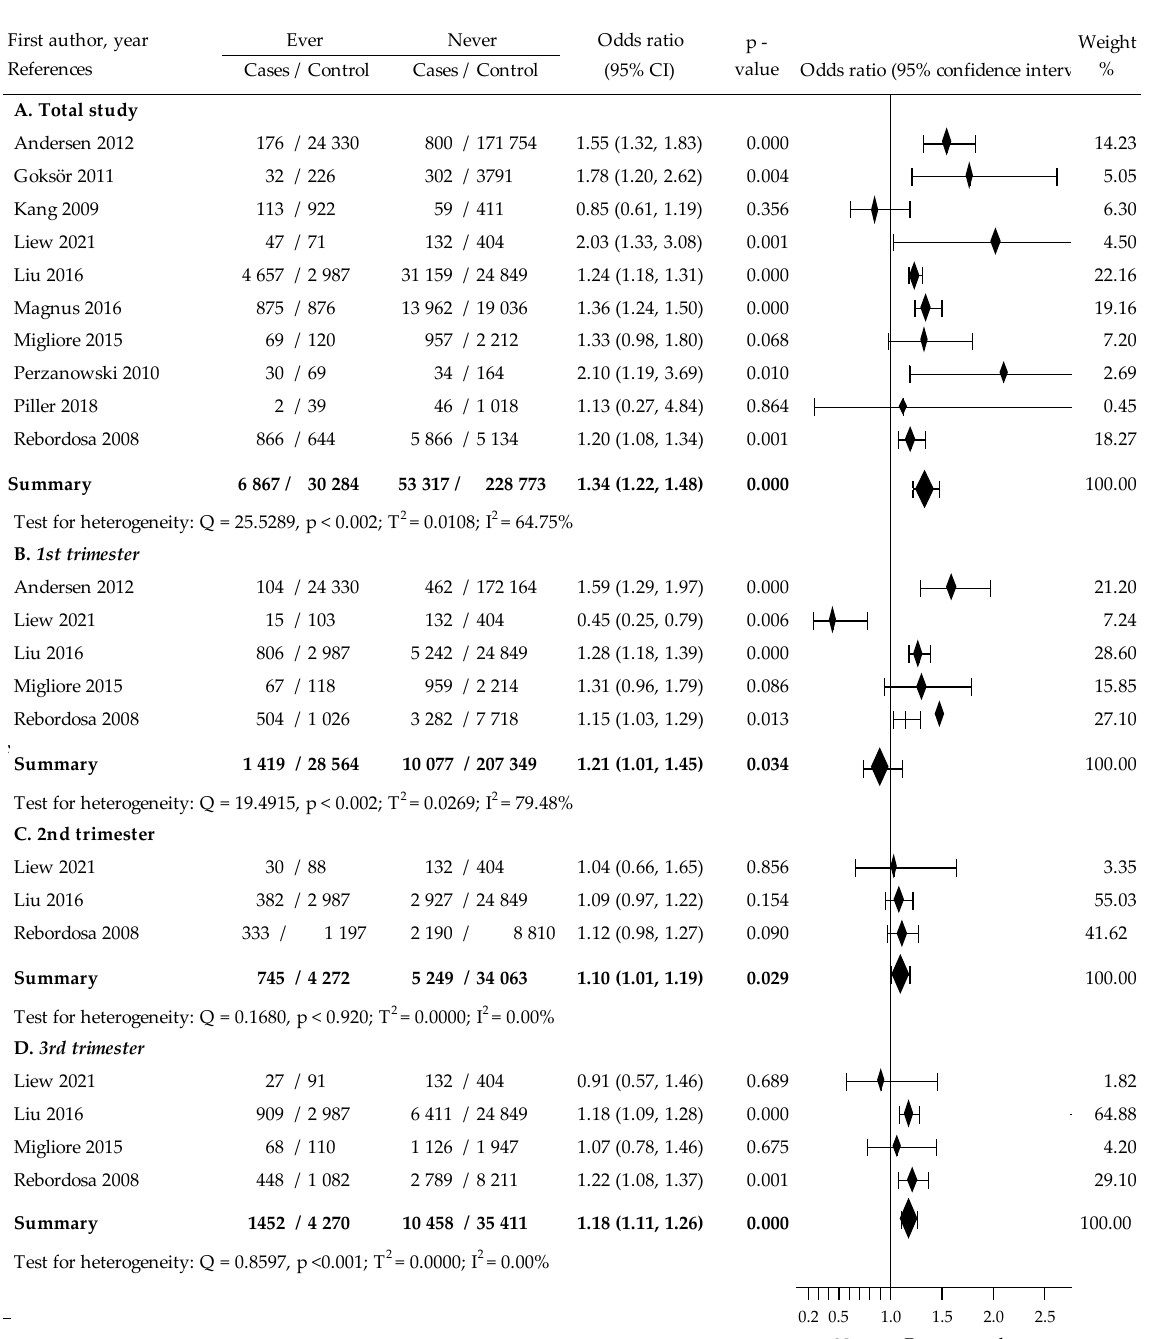
Figure 2. The crude relationship between childhood asthma and paracetamol use (ever vs. never) during pregnancy and each trimester of pregnancy [22–30,32]. 3.3. Association between Paracetamol Exposure during Pregnancy and Wheezing in Children In the eight studies [22,26,28–33] analyzed in order to assess prenatal paracetamol exposure during any time of pregnancy, we noted a significant increased risk of child- hood wheeze (crude OR = 1.31, 95% CI: 1.12 to 1.54, p < 0.002; with relatively high heter- ogeneity, I 2 = 75.29%), (Figure 3). The Begg and Mazumdar’s test for rank correlation in- dicated no evidence of publication bias (Kendall’s tau b = 0.333, z = 0.939, p < 0.349). Eg- ger’s test for regression intercept also demonstrated no evidence of publication bias (b0 = 2.161 (95% CI: − 1.775 to 6.097), t = 1.344, p < 0.229).